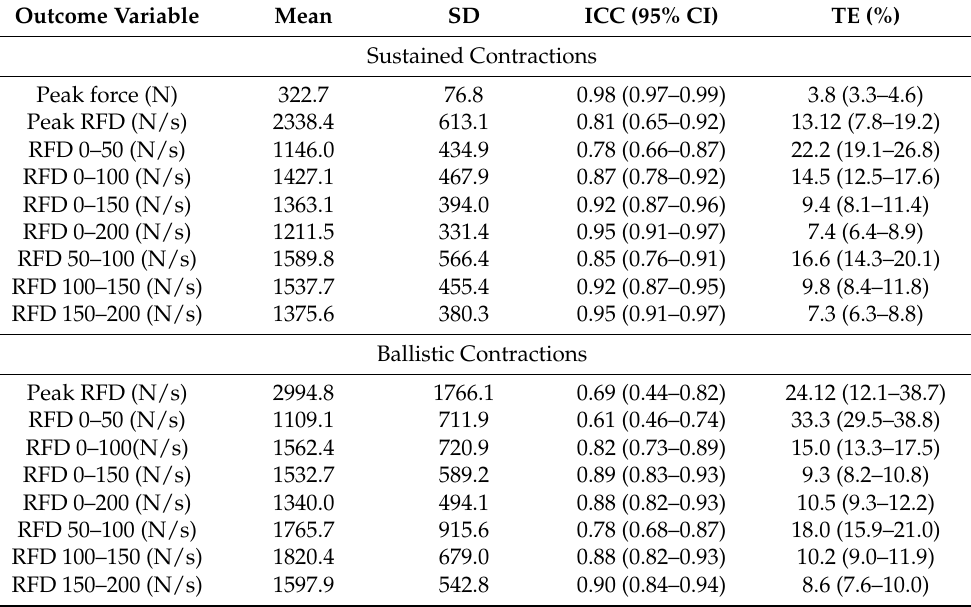
Table 1. Descriptive statistics and reliability analysis for ankle extension task.